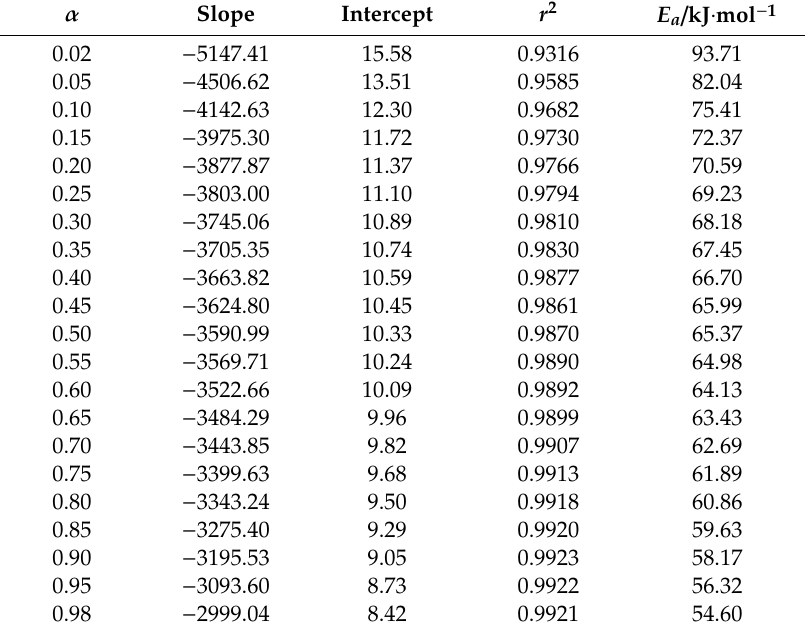
Figure 3. The lg β -1 / T fitting curves of AG-80 / m-XDA system ( phr = 26) at di ff erent conversion rates ( α = 0.02~0.98) by Flynn–Wall–Ozawa (FWO) method . Table 3. The fitting results for AG-80 / m-XDA curing system ( phr = 26) obtained by FWO method at di ff erent conversion rates ( α = 0.02~0.98) .